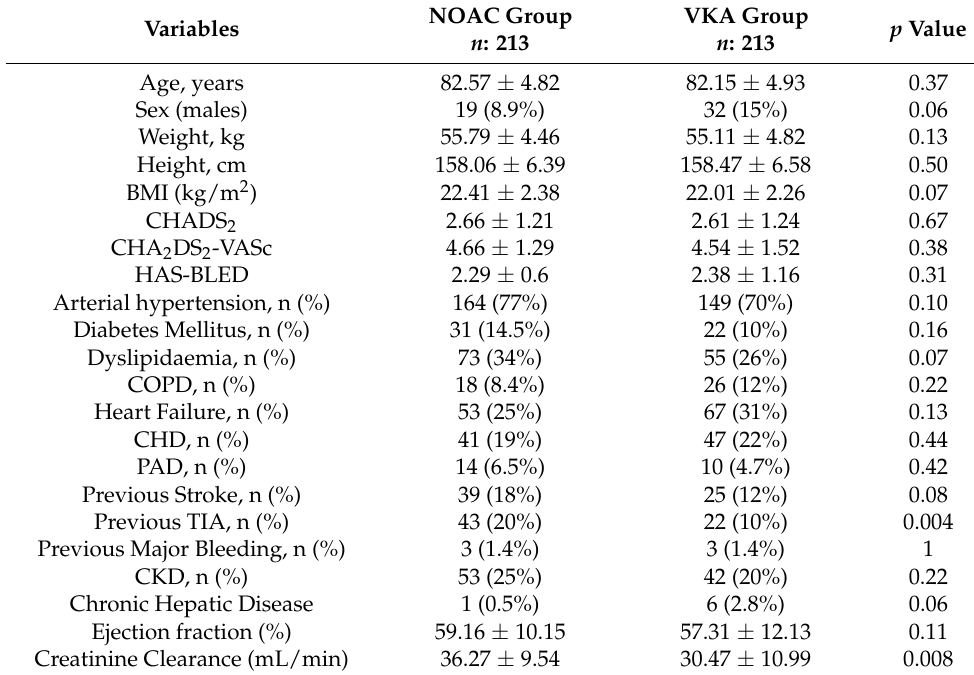
Table 2. Clinical characteristics of matched study